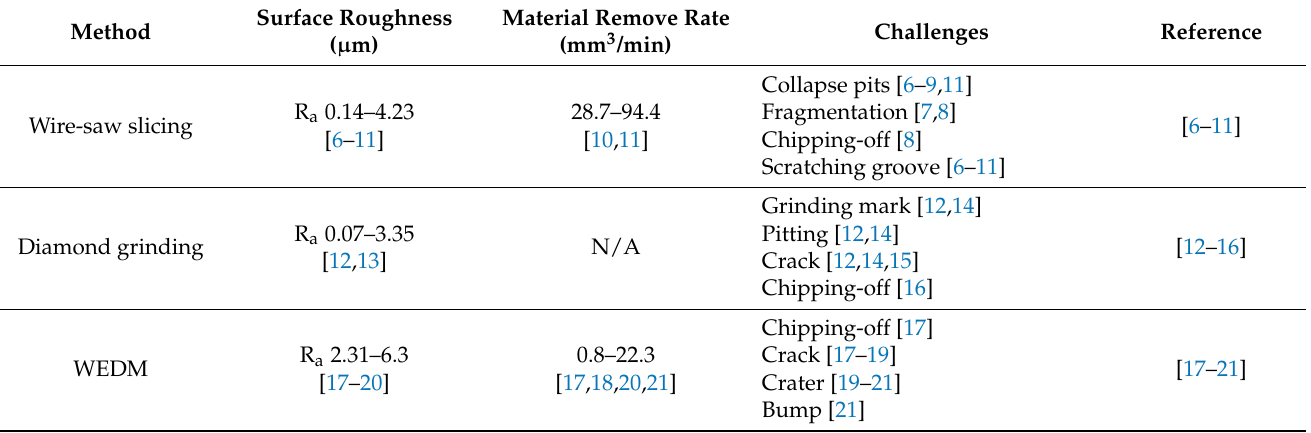
Table 1. Comparison of methods used in processing of silicon wafers